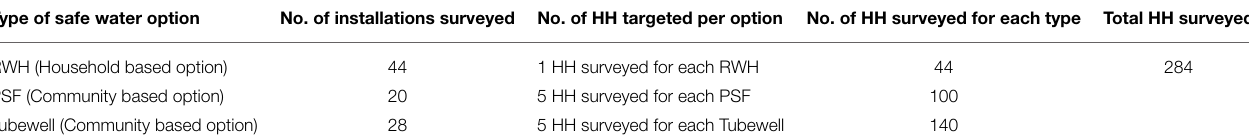
TABLE 2 | Household (HH) survey plan and coverage.